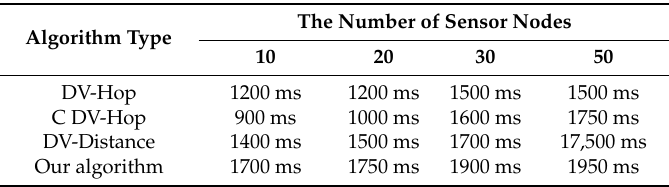
Table 2. Effect factors of localization time (case